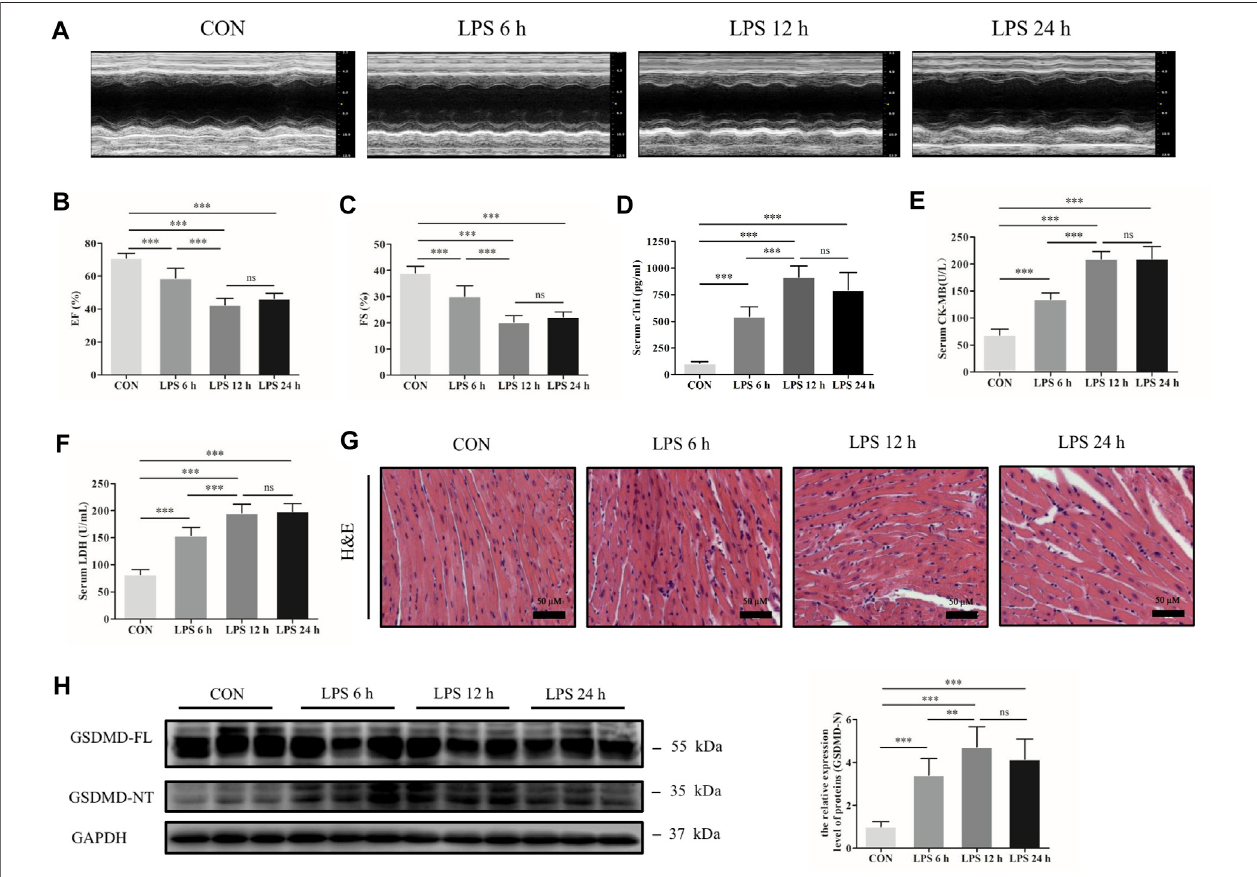
FIGURE1| GSDMD-NTwasupregulatedinthehearttissueofseptic mice inducedbyLPS. (A) Representativeechocardiographyofmice fromeach group. (B,C) Myocardial function parameters, ejection fraction (EF) and fractional shortening (FS) of mice from each group were assessed by echocardiography (n (cid:1) 6). (D – F) The levels of cardiac troponin I (cTnI), creatine kinase isoenzymes MB (CK-MB) and lactate dehydrogenase (LDH) in serum from each group (n (cid:1) 6). (G) Representative HE images of heart tissue from each group (magni fi cation × 400). (H) Expressions of GSDMD and GSDMD-NT protein in heart tissue were measured by Western blottinganalysis.TheresultswerenormalizedtotheexpressionofGAPDH(n (cid:1) 6).Dataareexpressedasthemean ± standarddeviation(SD).** p < 0.01,*** p < 0.001.ns: nonsigni fi cance.